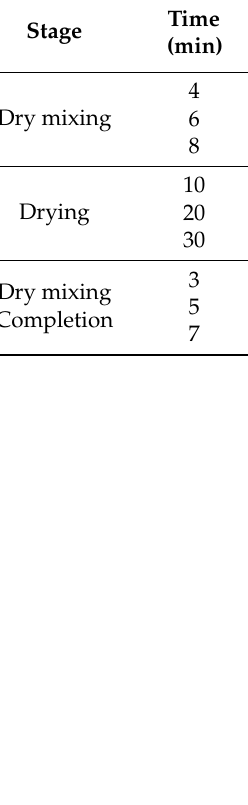
Table 4. Optimal process of metoprolol succinate layer in three